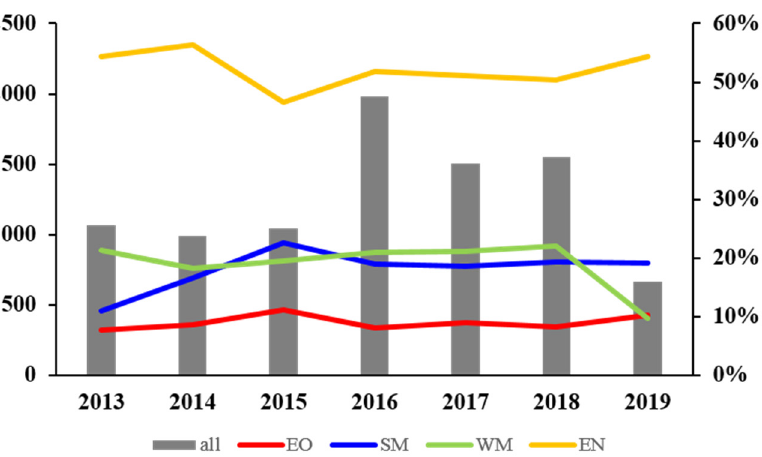
Figure 8. Annual variation of MCS number (gray columns) and proportion of EOs (red), SMs (blue), WMs (green) and ENs (yellow) from 2013 to 2019.